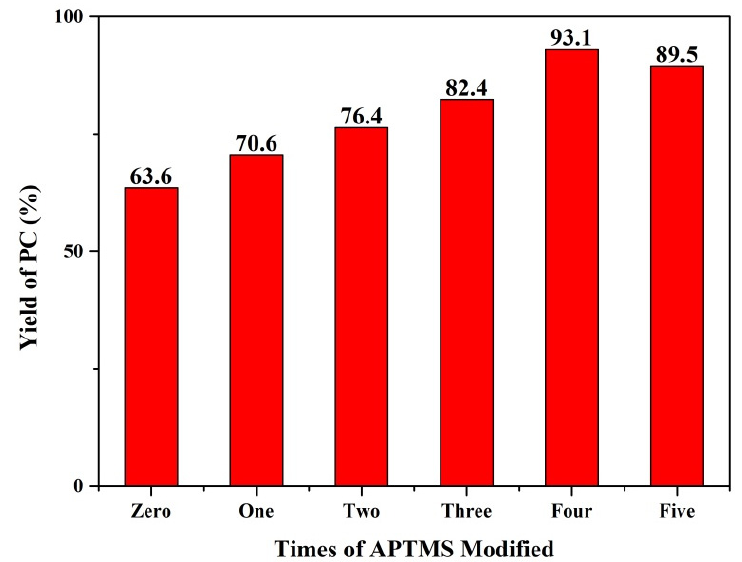
Figure 11. The histograms of the PC yield for CO 2 /PO cycloaddition reactions using the APTMS- modified Zr–Mg mixed oxide aerogels with Zr/Mg molar ratio of 7/3 under different times of APTMS modification.